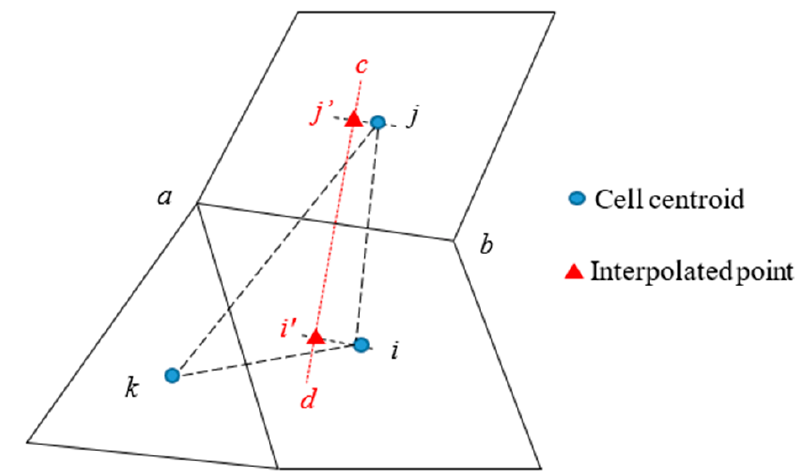
Figure 2. Example cells of unstructured grids.